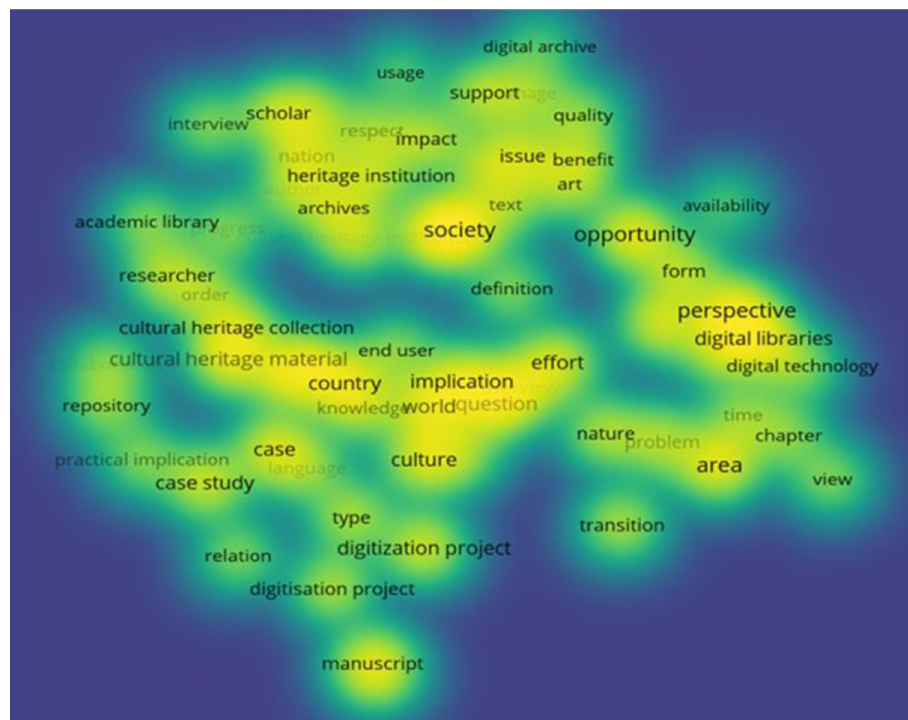
Fig 3. Word density map used in title and summary.